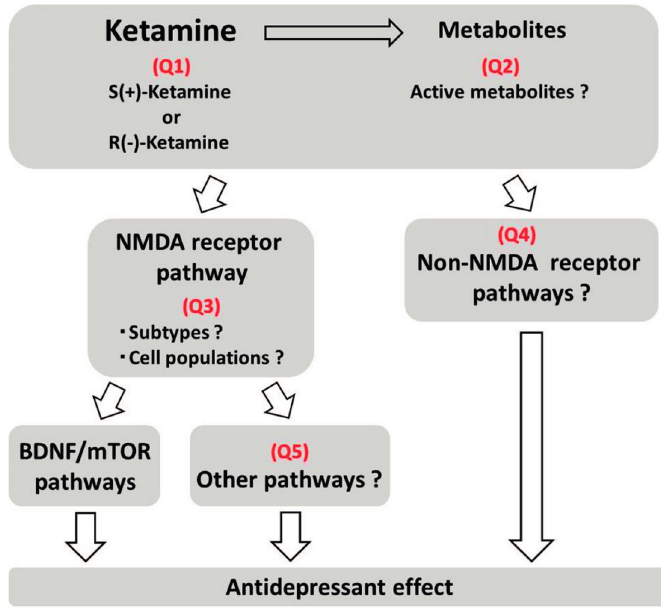
Figure 2. Issues to be solved on mechanisms of antidepressant effects of